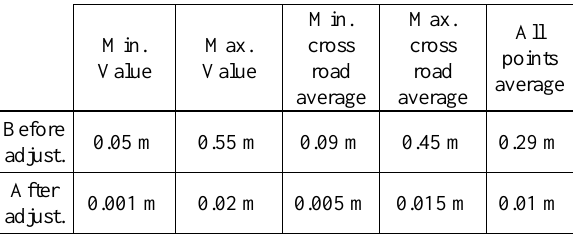
Figure 12. Cross section showing the perpendicular angle of the point cloud, after registration.